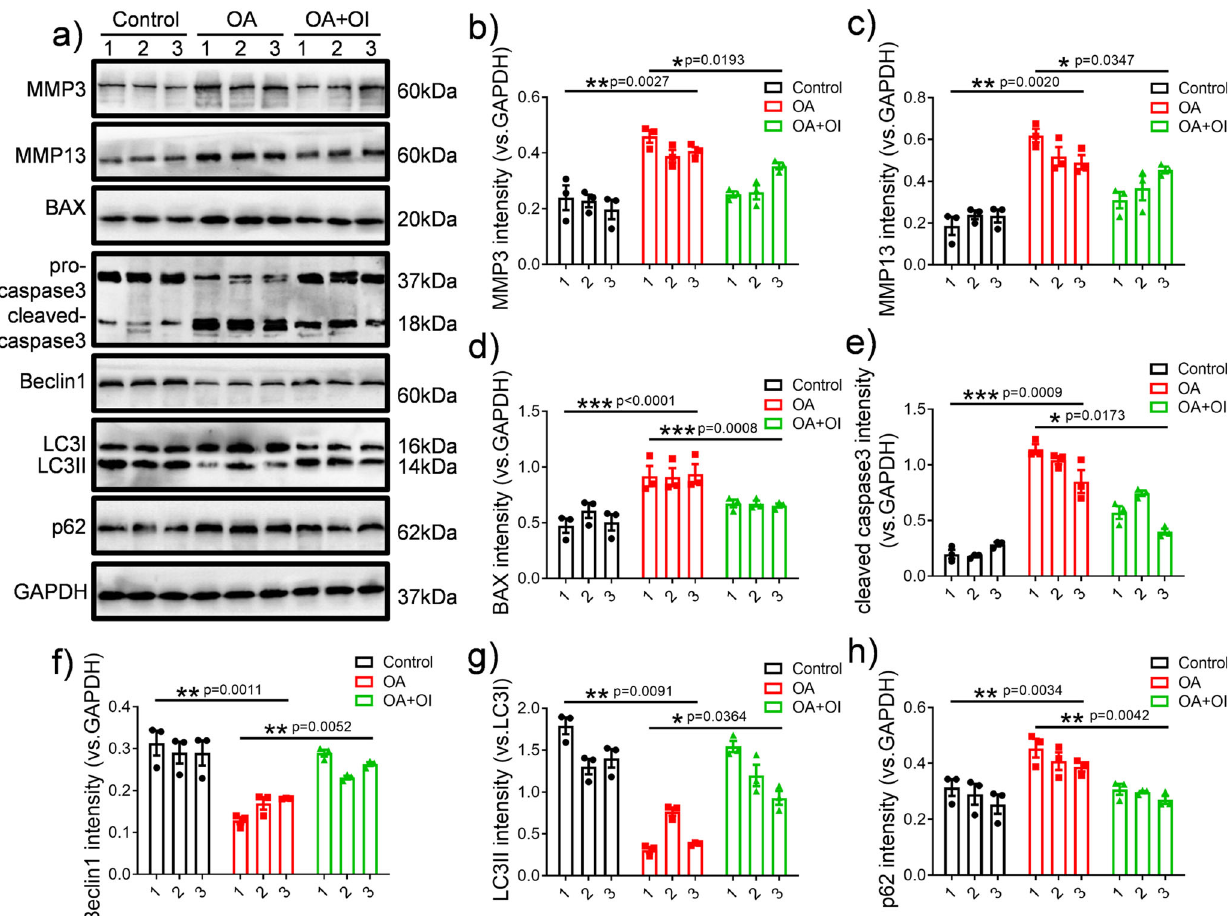
Fig. 7 Effects of OI on the expression of cartilage degradation-related proteins, apoptosis-related proteins and autophagy-related proteins in OA rats. a The expression levels of MMP3, MMP13, BAX, pro-caspase3, cleaved caspase3, LC3, Beclin-1, p62, and GAPDH in rats were determined by western blotting and b – h normalised to that of GAPDH ( n = 3). The error bar is SD. The data are the mean ± SD. * P < 0.05, ** P < 0.01, *** P <